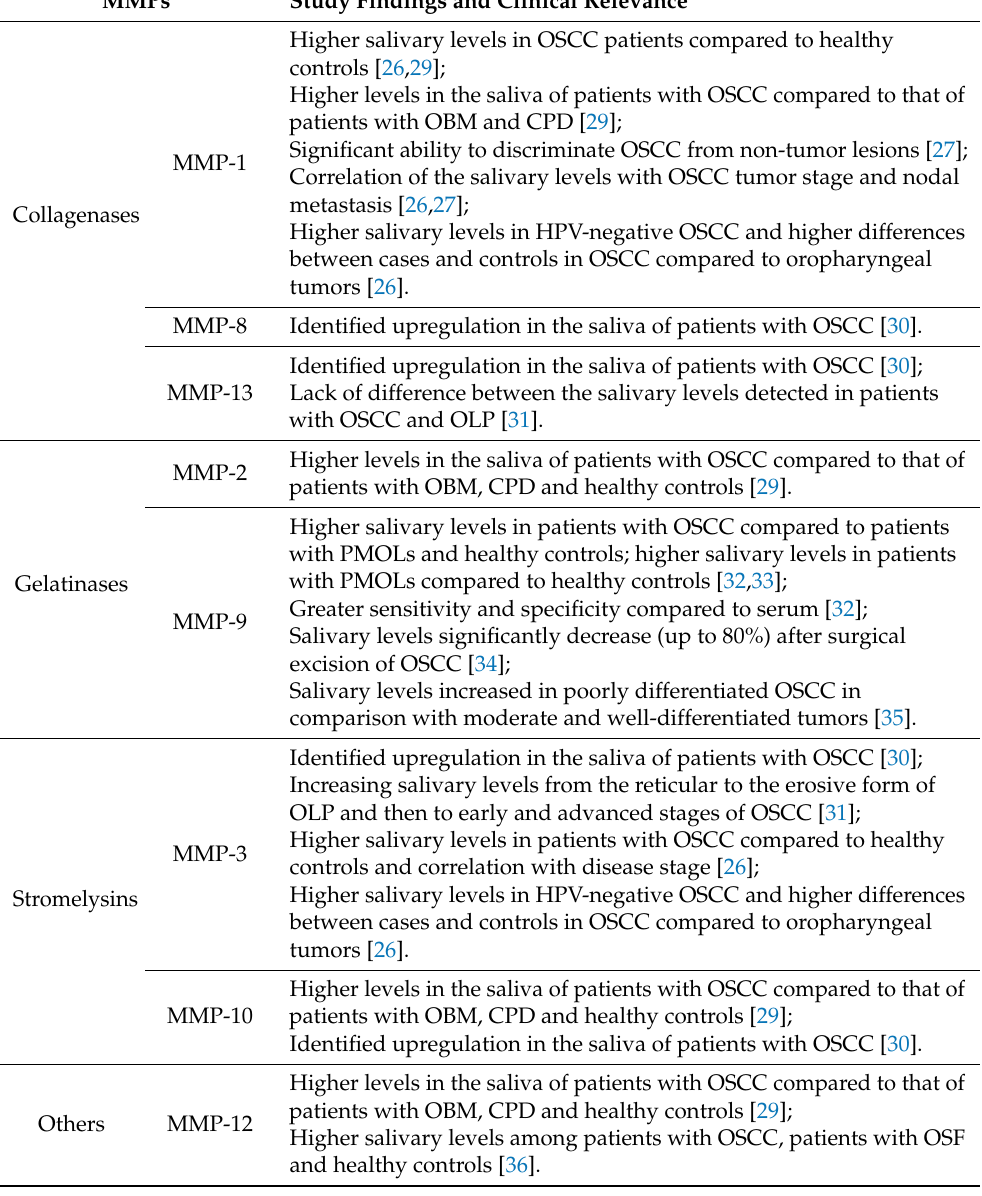
Table 2. Significance of the salivary levels of MMPs in PMOLs and